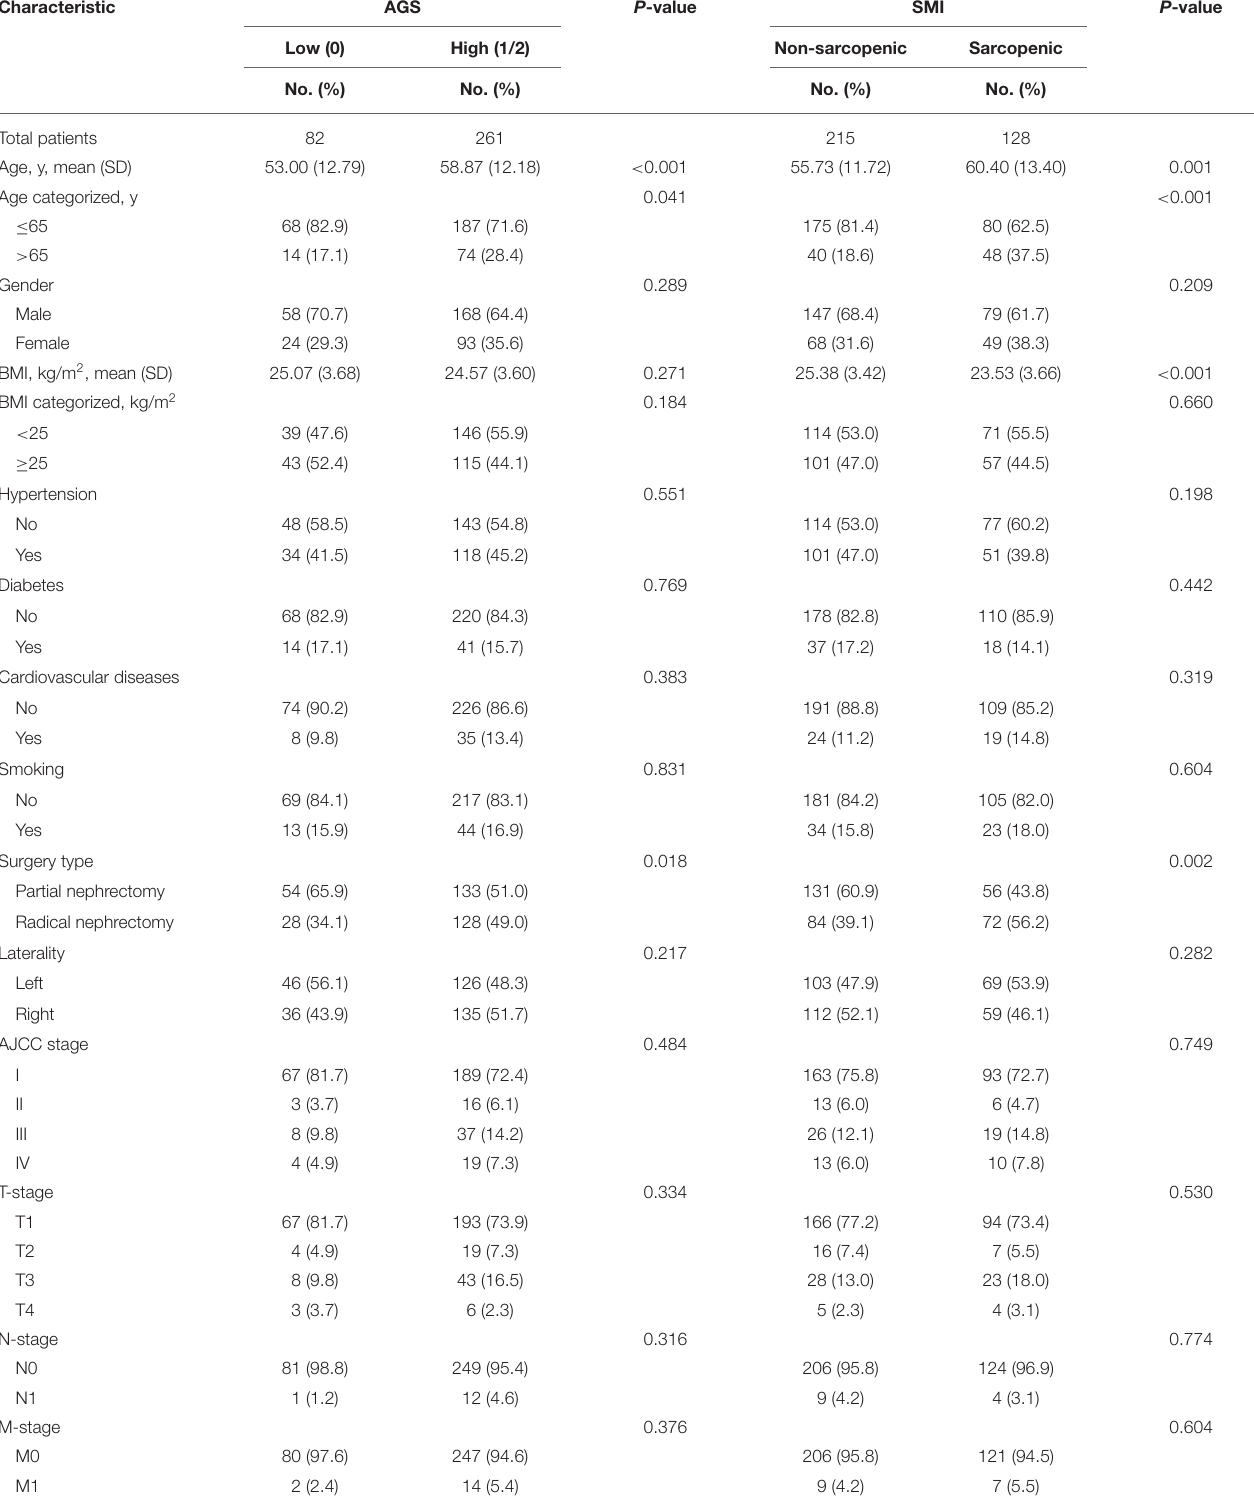
TABLE 2 | Comparison between AGS, SMI and clinic pathological characteristics in training set.